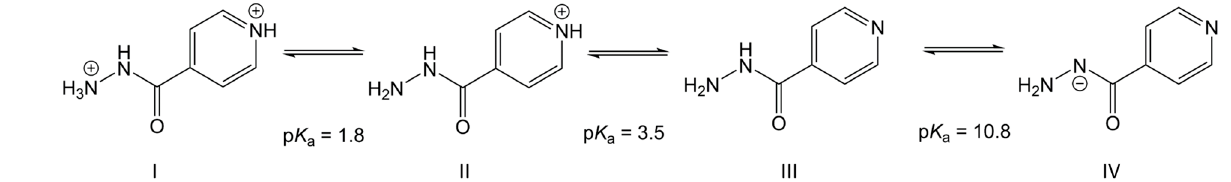
Figure 5. Distribution of chemical species of isoniazid at different pHs ( I – IV ).